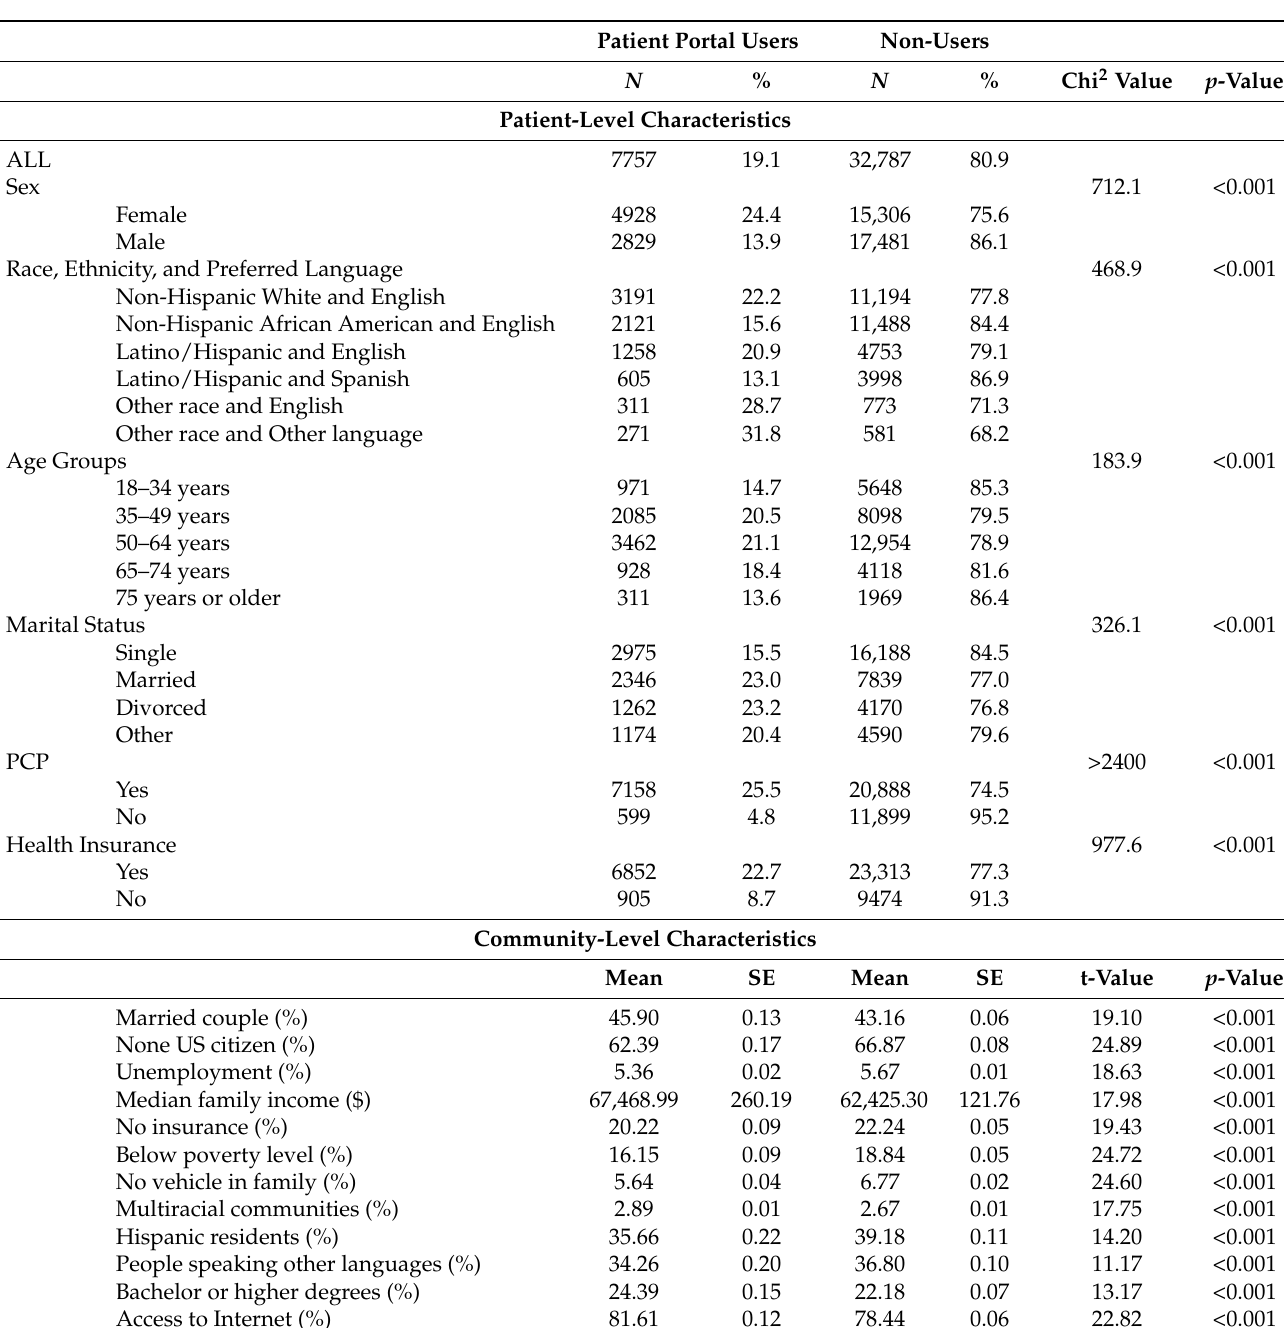
Table 3. Number and row percentages of adults with multimorbidity with ED visits by patient portal (My Chart) use, linked electronic health records with American Community Survey